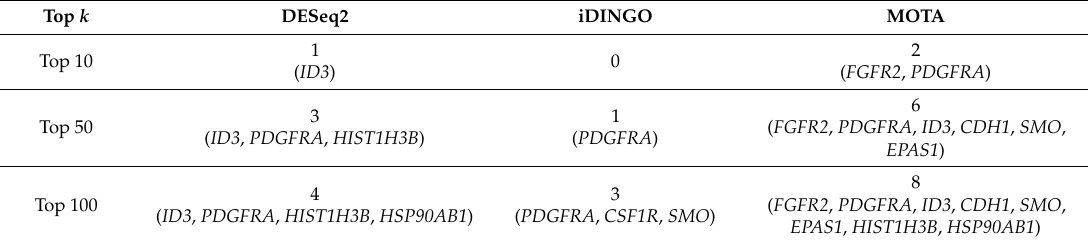
Table 5. Number of cancer driver genes selected using DESeq2, iDINGO, and